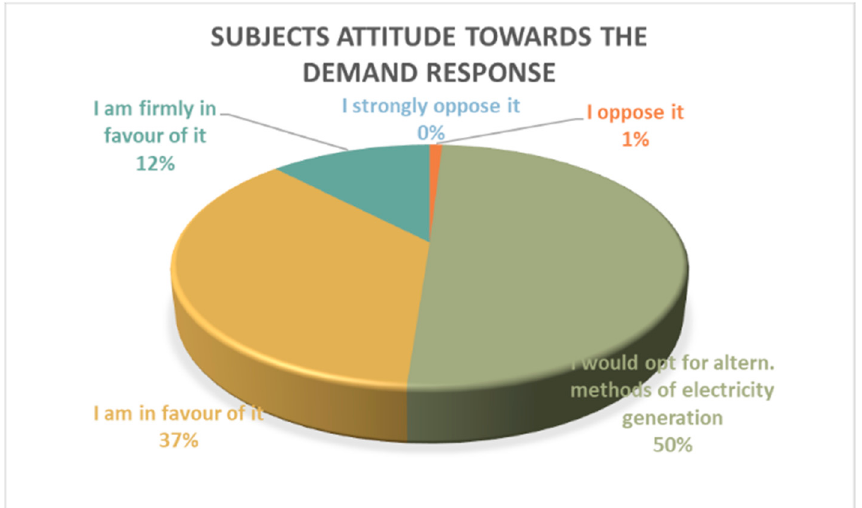
Figure 6. Consumers’ attitudes towards the Demand Response.